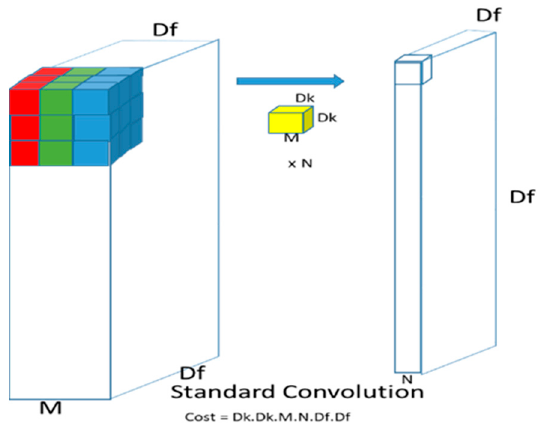
Figure 1. Standard Convolution.